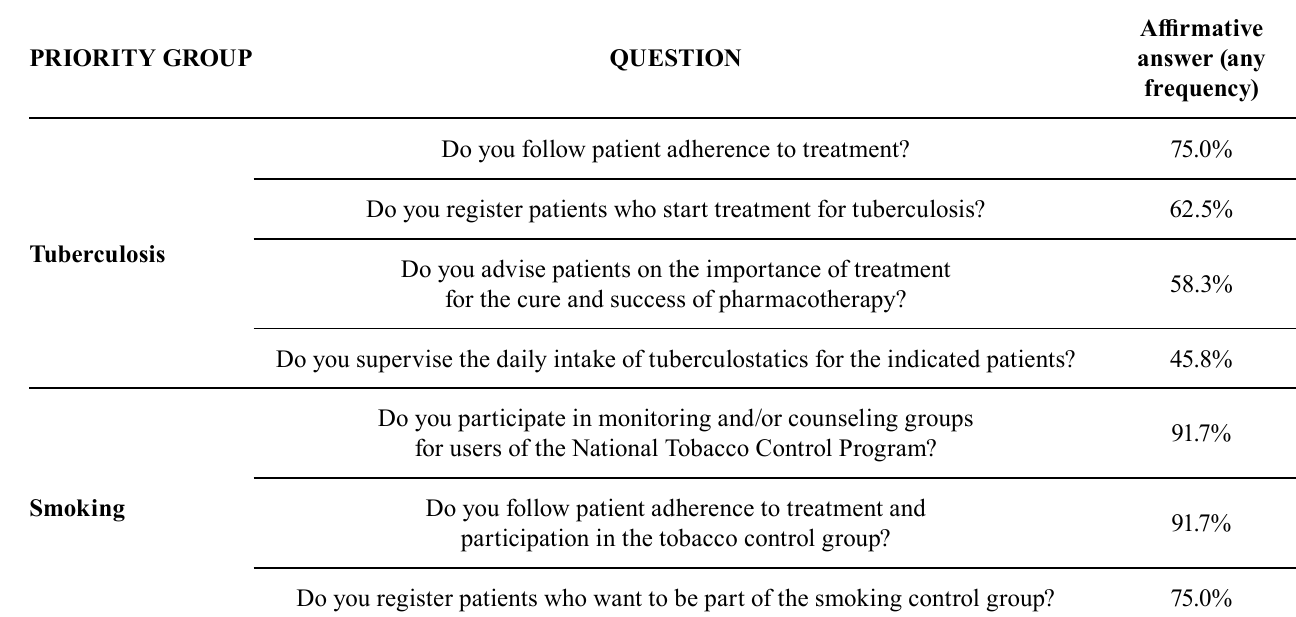
TABLE VI – Pharmaceutical Care activities carried out in priority groups in primary health center (UBS) of São Bernardo